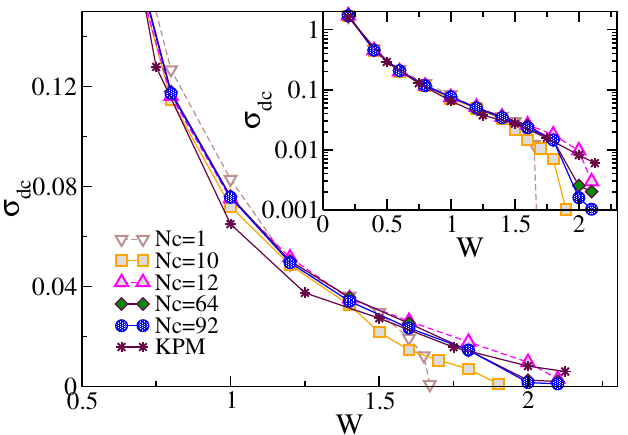
Figure 39. DC conductivity of the 3D Anderson model at T = 0 and µ = 0 (band center) vs. disorder W for different cluster size N c = 1,10, 12,64,92. The DC conductivity vanishes at W c where all states become localized. For N c = 1 (TMT), the critical disorder strength W N c = 1 c cluster size increases, W c systematically increases with W N c (cid:29) 12 c showing a quick convergence with cluster size to the KPM result. Reprint from